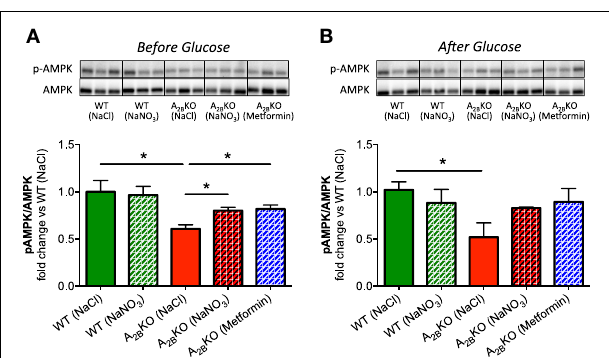
FIGURE 6 | AMPK regulation in the liver. Western blot was used to determine AMPK expression and phosphorylation in liver. Before (A) and after glucose injection (B) , A 2B KO mice showed significantly lower AMPK activation compared to WT. This could be improved by prior injection of nitrate or metformin. Three representative samples per group obtained from different gels are shown together with densitometric quantification, presented as ratio p-AMPK/AMPK. Values are mean ± SEM, n = 4 /group. * p < 0 . 05 among the indicated